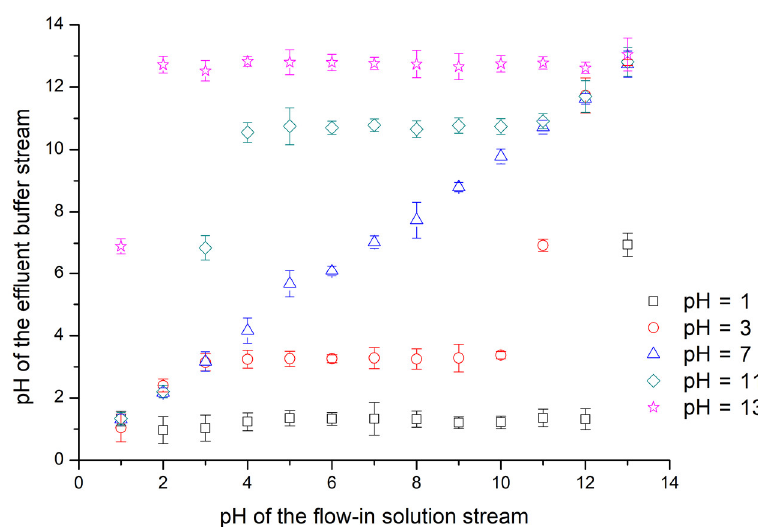
Figure 6. Experimental results of pH values of flowing out buffer streams along the diffusion channel. Buffer streams (HCl or NaOH solutions with a pH value of 1, 3, 7, 11 or 13) are pumped into a 10 mm diffusion channel with solution streams (HCl or NaOH solutions). The width of diffusion channel is 100 µ m. The volumetric flow rates for two laminar streams are 1 µ L · min − 1 . The outflows reach an even ionic distribution after the reaction between acid and alkaline in the flow-through time along the diffusion channel. The presented experimental results are averaged from five tests.